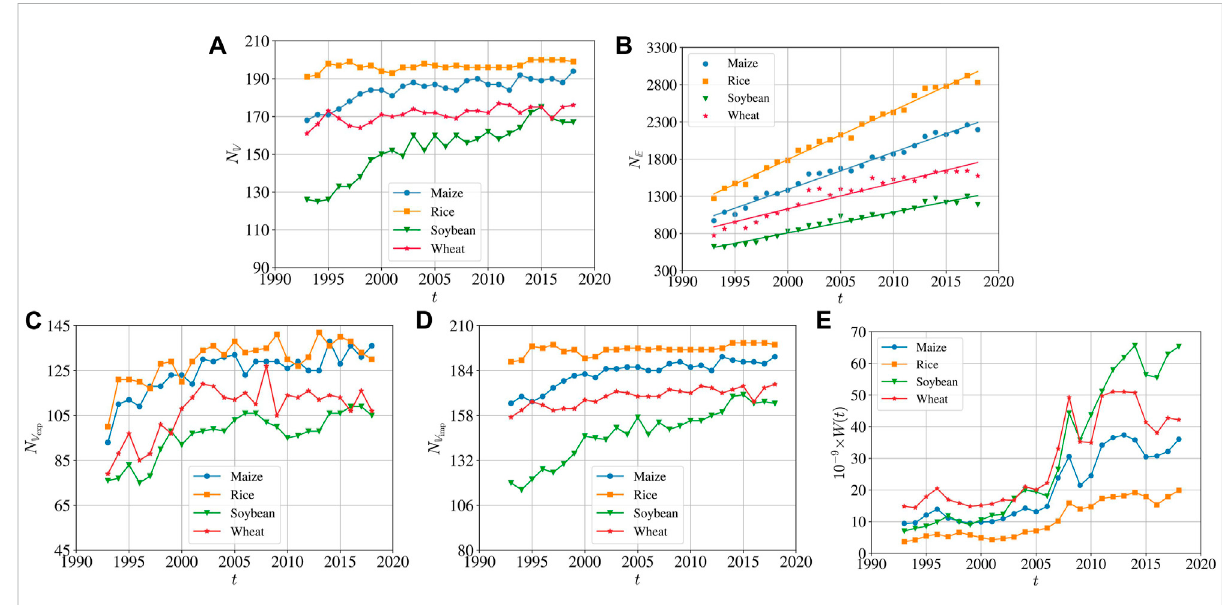
Evolution of the summary statistics of the four iCTNs from 1993 to 2018. (A) Number of nodes N V . (B) Number of links N E . (C) Number of exporting economies N